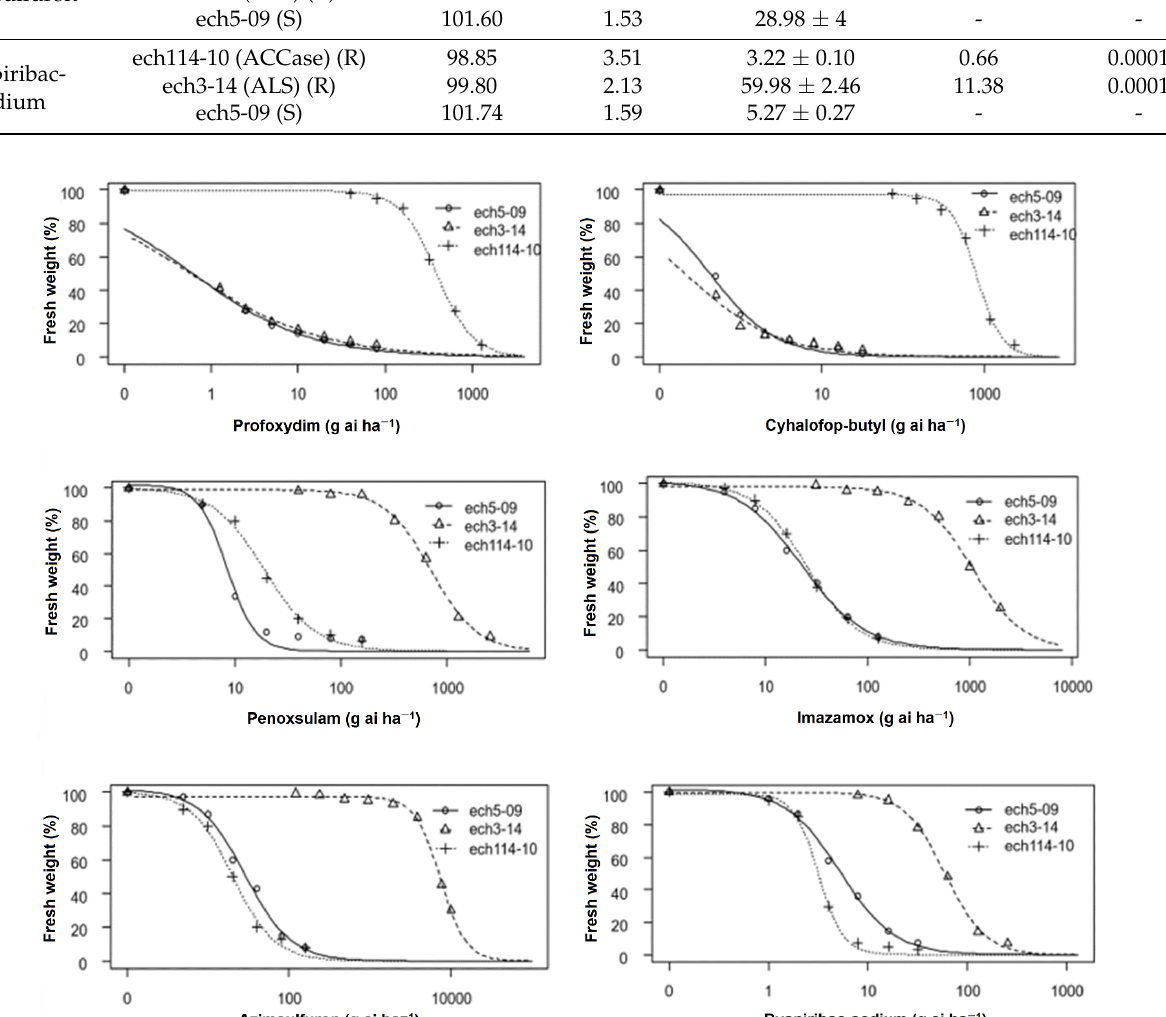
Figure 2. Profoxydim, cyhalofop-butyl, penoxsulam, imazamox, azimsulfuron, and bysipiribac-sodium dose—response was on fresh weight reduction and expressed as a percentage of the mean untreated control of the R (ech114-10 and ech3-14) and S (ech5-09) populations. Symbols denote mean ( n = 6) ± SEM.